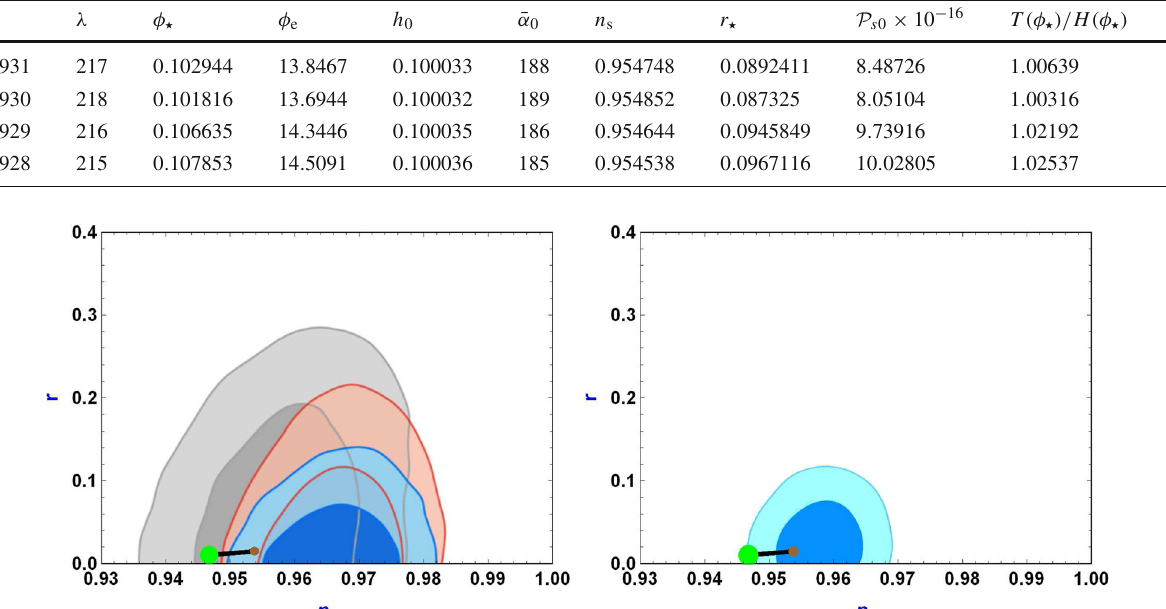
bluecontours.Intherightpanel,theresultsofPlanck2018areindicated by dark and light blue colors corresponding to68% and 95% confidence levels, respectively. In both figures the thick black lines refer to the the- oretical predictions, with the small, brown, and large, green, circles corresponding to the values of n s at the number of e-folds N = 50 and N = 55, respectively